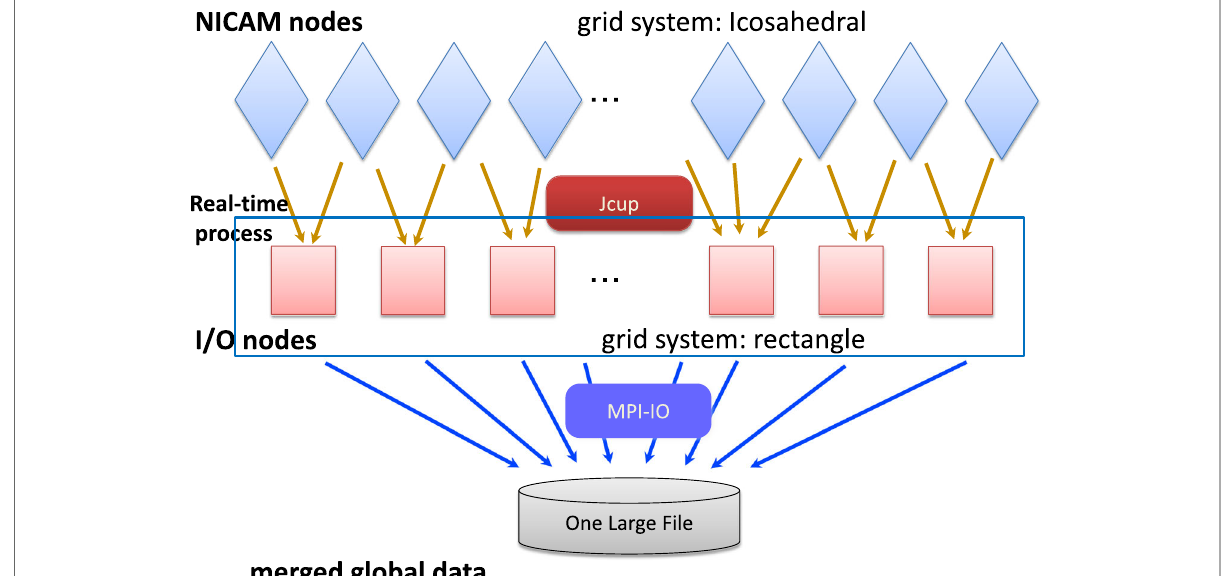
Fig. 9 The overview of IO component for NICAM. A blue square indicates NICAMIO